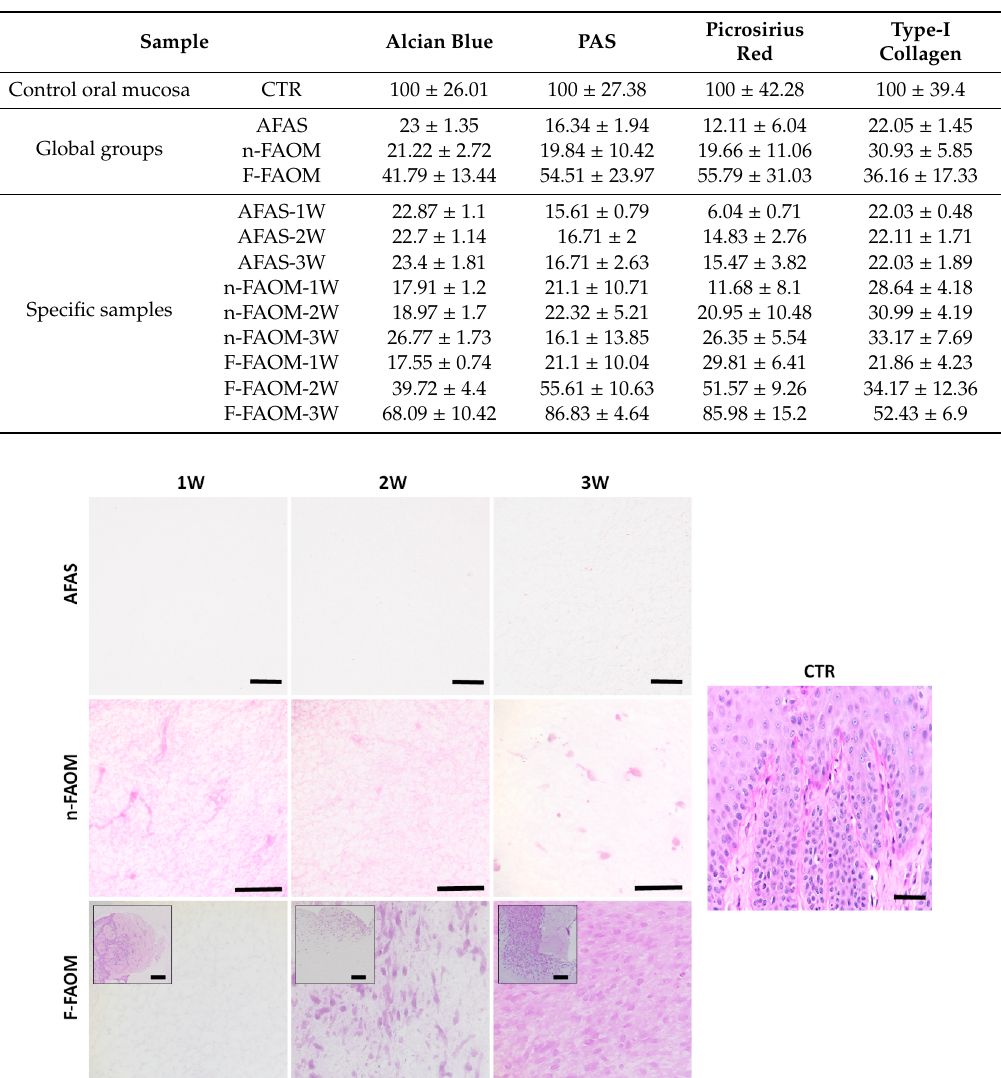
Table 1. Quantitative evaluation of proteoglycans, glycoproteins, mature collagen fibers and type-I collagen as determined by alcian blue, PAS, Picrosirius red Histochemistry, and type-I collagen immunohistochemistry, respectively. Values correspond to average ± standard deviation of the staining intensity found for each sample type normalized to control oral mucosa samples (CTR).